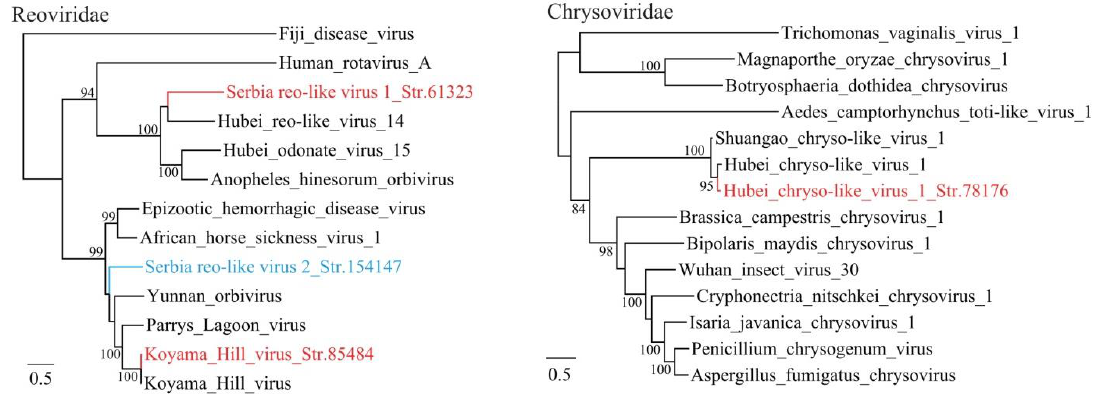
Figure 3. Phylogenetic analysis of dsRNA viruses including Reoviridae and Chrysoviridae. The phylogenetic trees were inferred using the ML method, with 1000 bootstrap replicates and mid-point rooting. Red: viruses from mosquitoes ( Culex Pipiens ), blue: virus from bedbugs ( Cimex lectularius ).